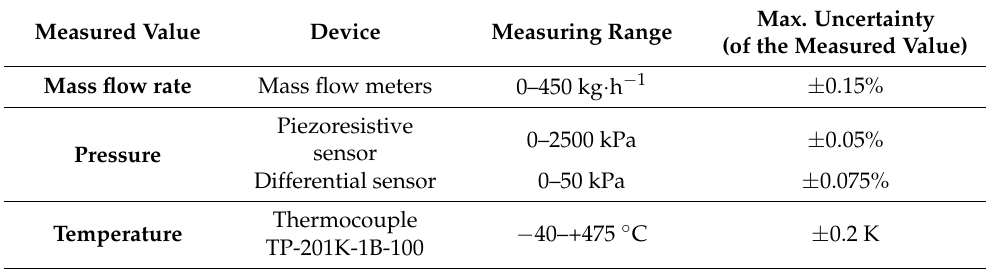
Table 1. The measuring equipment uncertainty.